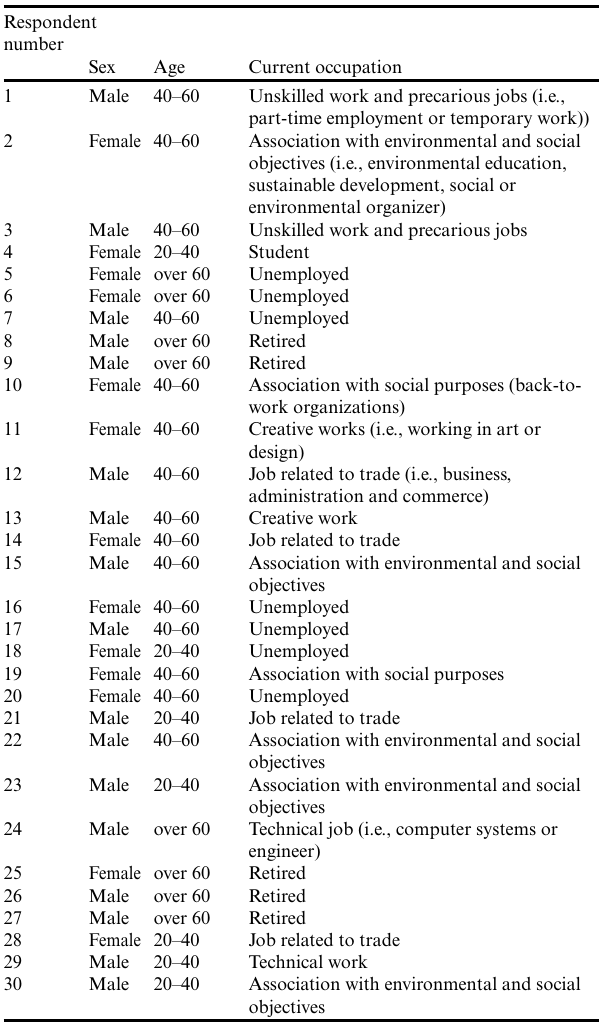
Table 3. Interviewed community